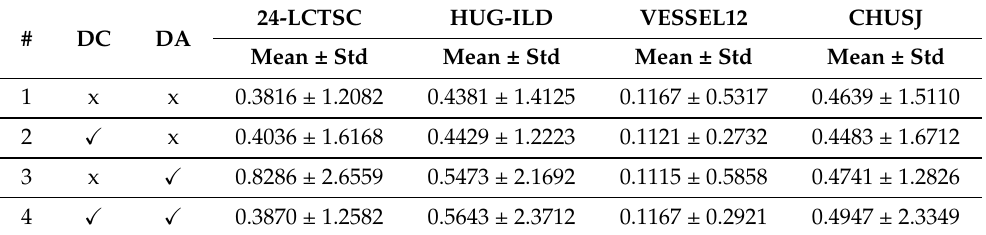
Table 5. Mean and standard deviation (std) results of the average symmetric surface distance (ASSD) for each dataset and for each experiment. For simplicity purposes a number is assigned to each experiment, as indicated in the first column, # . The DA column corresponds to the data augmentation and the DC column corresponds to the data correction. The value x in these two columns indicates experiments without DA or DC and the value (cid:88) indicates experiments with DA or DC. The values of the ASSD can lie in the range 0–181.0193